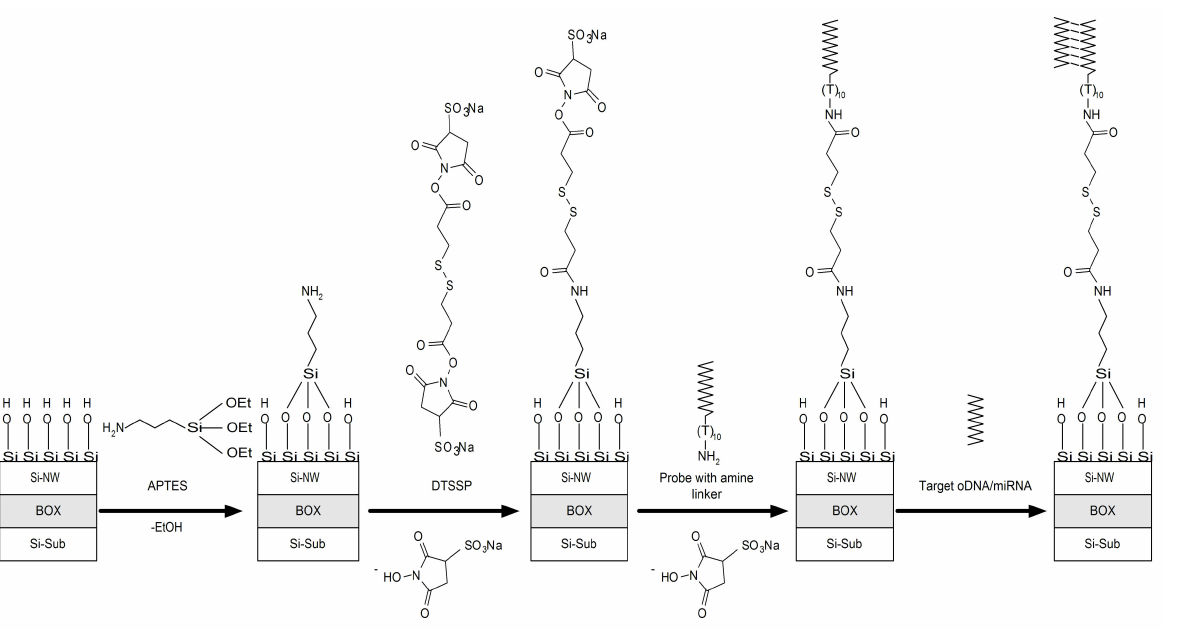
Figure 3. Schematic representation of Si-NR surface functionalization and target molecule